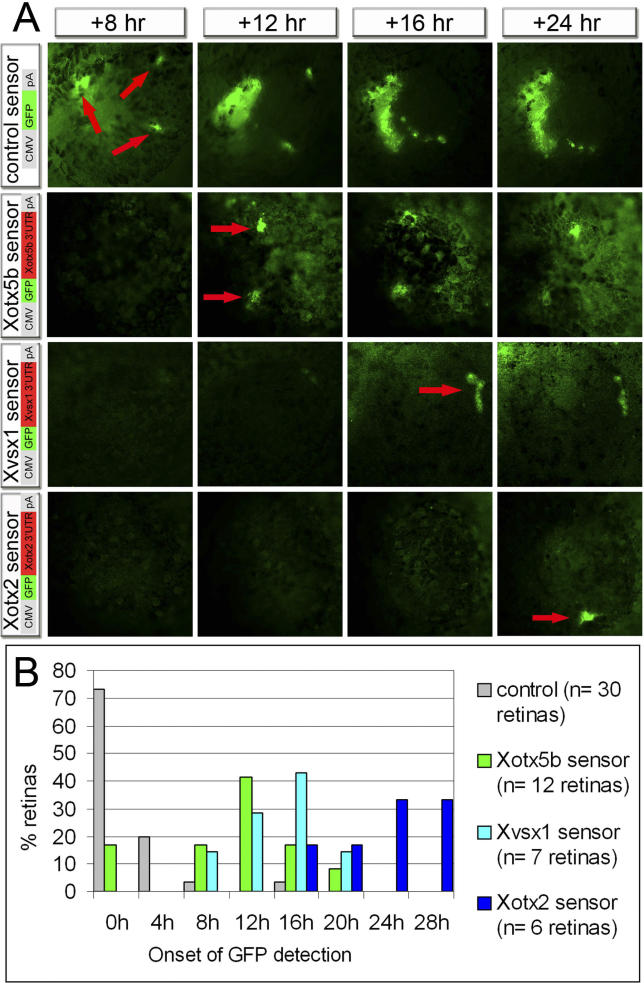
The 3′ UTRs of Xotx5b, Xvsx1, and Xotx2 mRNAs Direct Time-Dependent Inhibition of Translation(A) Examples of time-lapse imaging of lipofected retinas. Times are calculated starting from st. 30 [22] (which corresponds to time 0). To better visualize GFP, pigmentation was abolished as described [43]. Each micro-photograph shows the entire area of a lipofected eye and is focused on lipofected cells of the neural retina. Red arrows point to lipofected clones of cells.(B) Statistical analysis of 68 records. Bars express the proportion of lipofected retinas in which GFP was first detectable at a given time. Number of retinas examined is indicated by n.